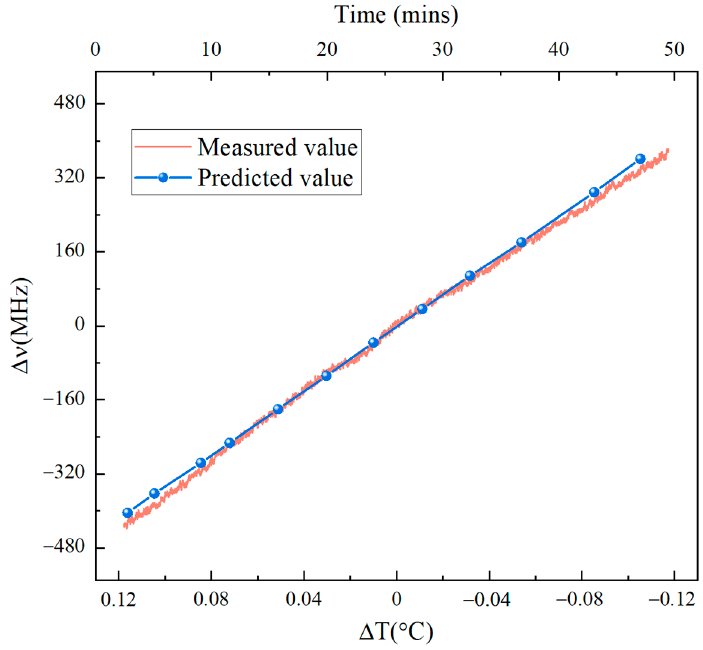
Figure 5. Measured and theoretical deviation in signal frequency as a function of temperature shift.